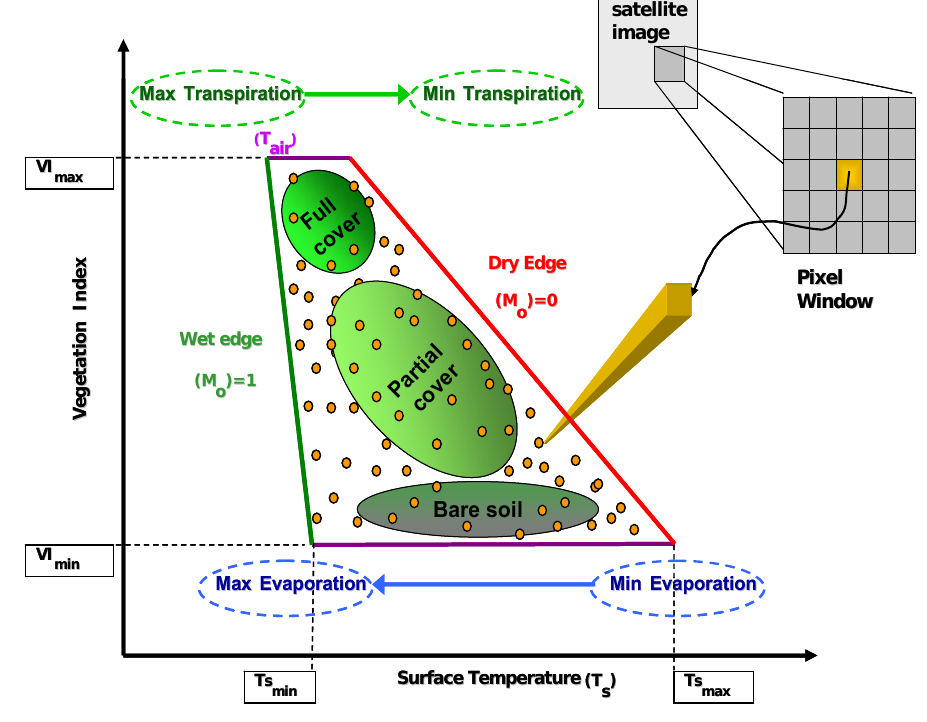
Figure 5. Summary of the main physical properties and interpretations of the satellite (or /VI feature space. Dots represent measurements at pixels observed by a airborne) derived T s VIS/TIR radiometer at various vegetation fractional covers (F (T ). In this illustration, pixels classified as water or clouds are assumed to have been s masked out. Figure is the product of a synthesis of figures presented by